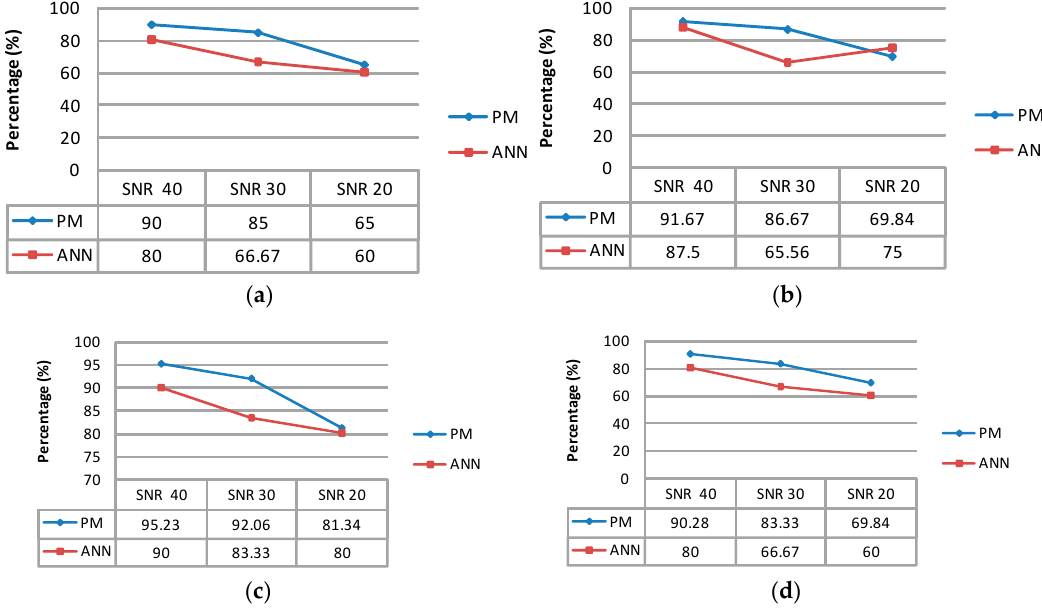
Figure 8. Result comparison of ( a ) accuracy; ( b ) precision; ( c ) specificity and ( d ) sensitivity between the proposed technique and the ANN.